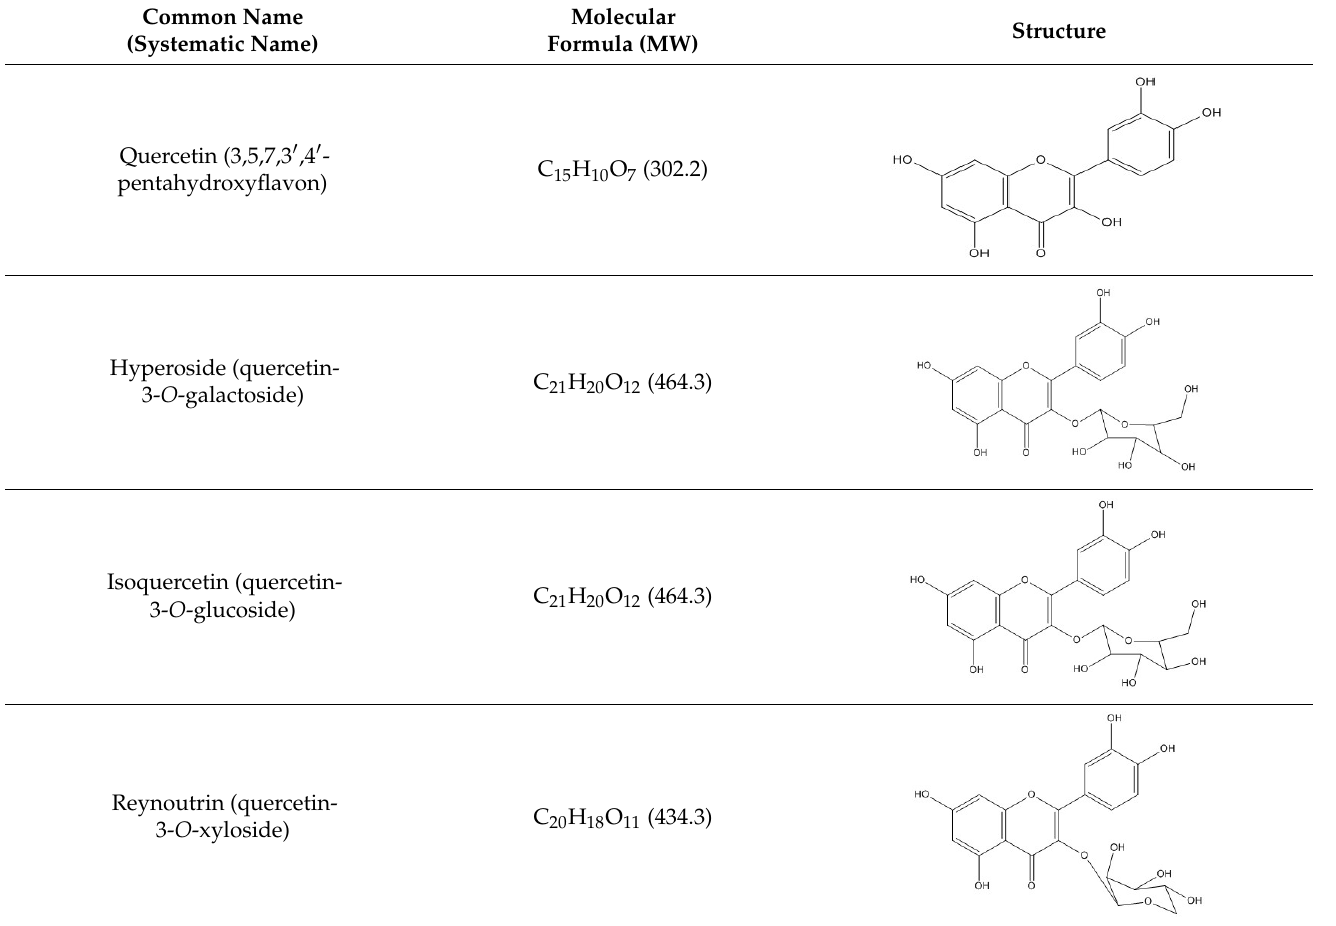
Table 1. Quercetin and its derivatives information (molecular weight and structure).